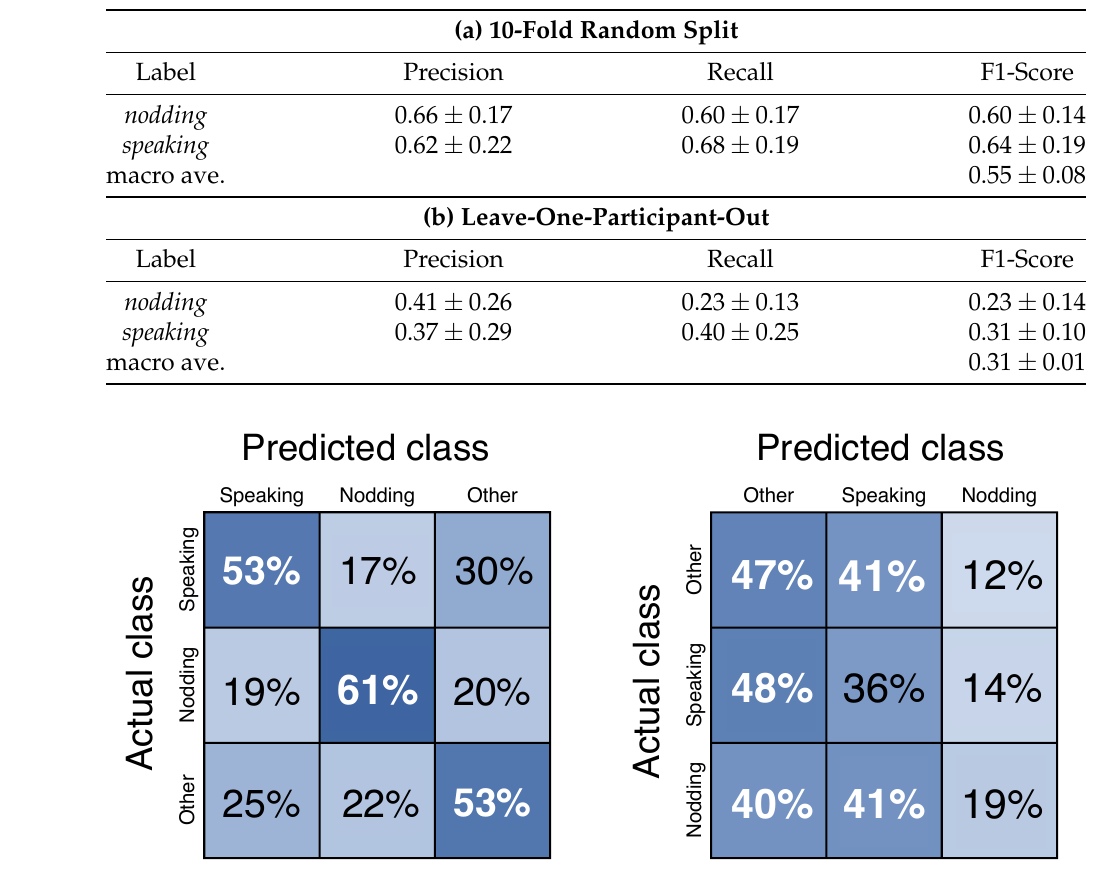
Table 3. Prediction Result of Nodding for Online Meeting.